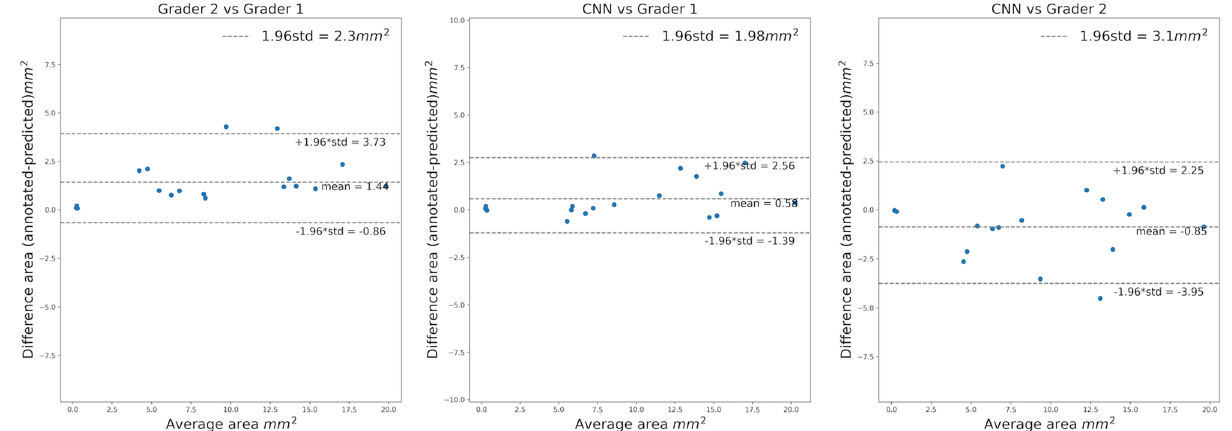
Figure 5. Bland–Altman plot illustrating RORA area differences between graders and our method.